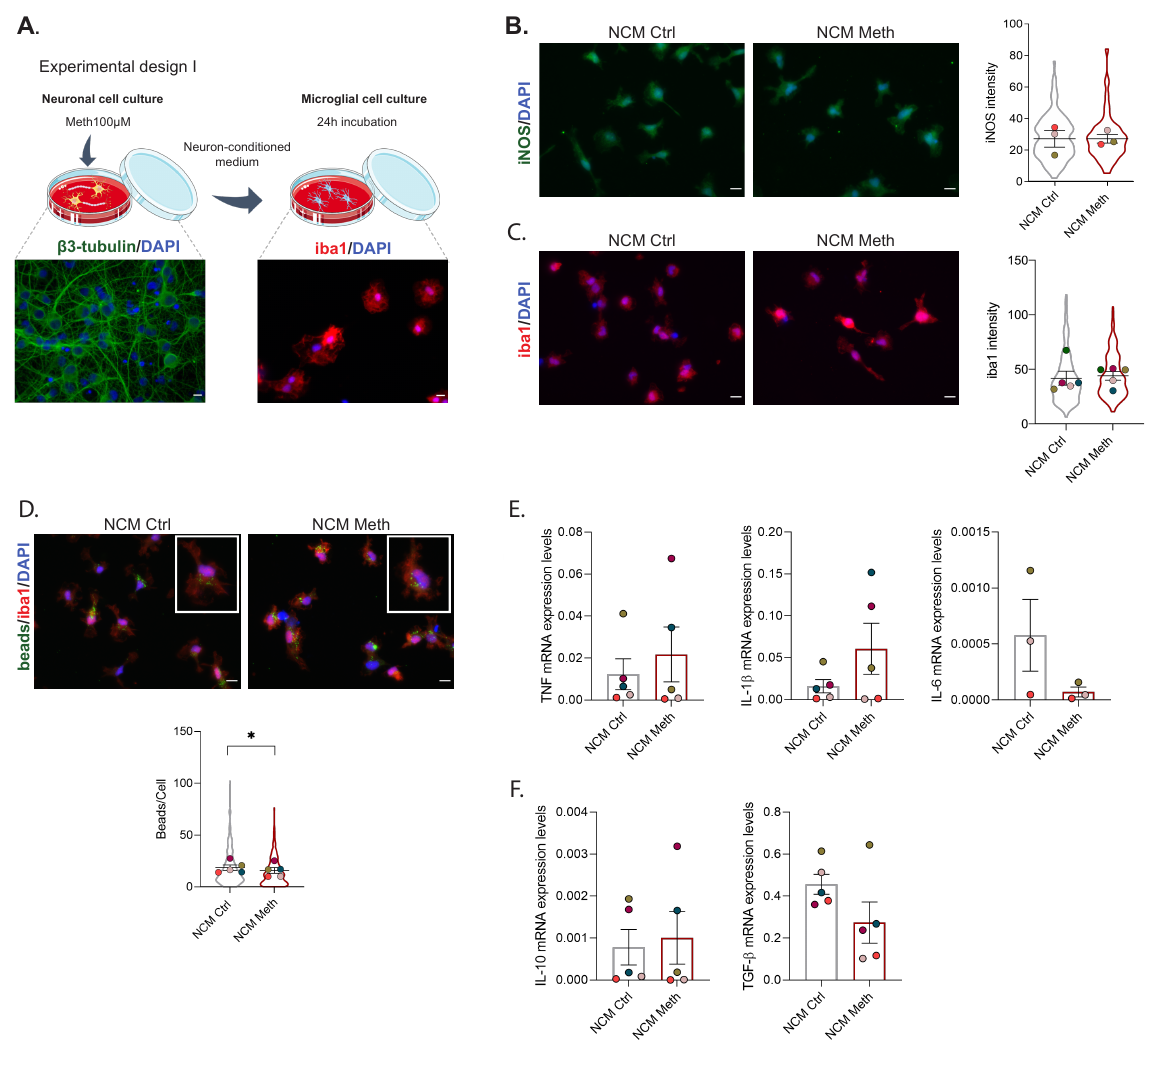
Figure 1. Neurons exposed to Meth do not promote microglial activation through contact- independent mechanisms. ( A ) Experimental design I—Neuronal cell cultures from the hippocampus were incubated with 100 µ M Meth for 24 h. Following that, primary microglial cell cultures were incubated for 24 h with the conditioned media obtained from neurons treated with Meth (NCM Meth) or from control neuronal cell cultures (NCM Ctrl). ( B ) Fluorescence imaging of microglial cells immunolabeled for iNOS (green) incubated with NCM Ctrl or NCM Meth for 24 h. Results express the iNOS intensity (mean ± SEM) of three independent cultures (NCM Ctrl—132 cells; NCM Meth—143 cells). ( C ) Fluorescence imaging of microglial cells immunolabeled for iba1 (red) incubated with NCM Ctrl or NCM Meth for 24 h. Results express iba1 intensity (mean ± SEM) of five independent cultures (NCM Ctrl—252 cells; NCM Meth—265 cells). ( D ) Fluorescence imaging of microglial cells immunolabeled for iba1 (red) incubated with microbeads (green) and treated with NCM Ctrl or NCM Meth for 24 h. Results represent the number of beads per cell (mean ± SEM) of five independent cultures (NCM Ctrl—267 cells; NCM Meth—264 cells). Statistical analysis for ( B – D